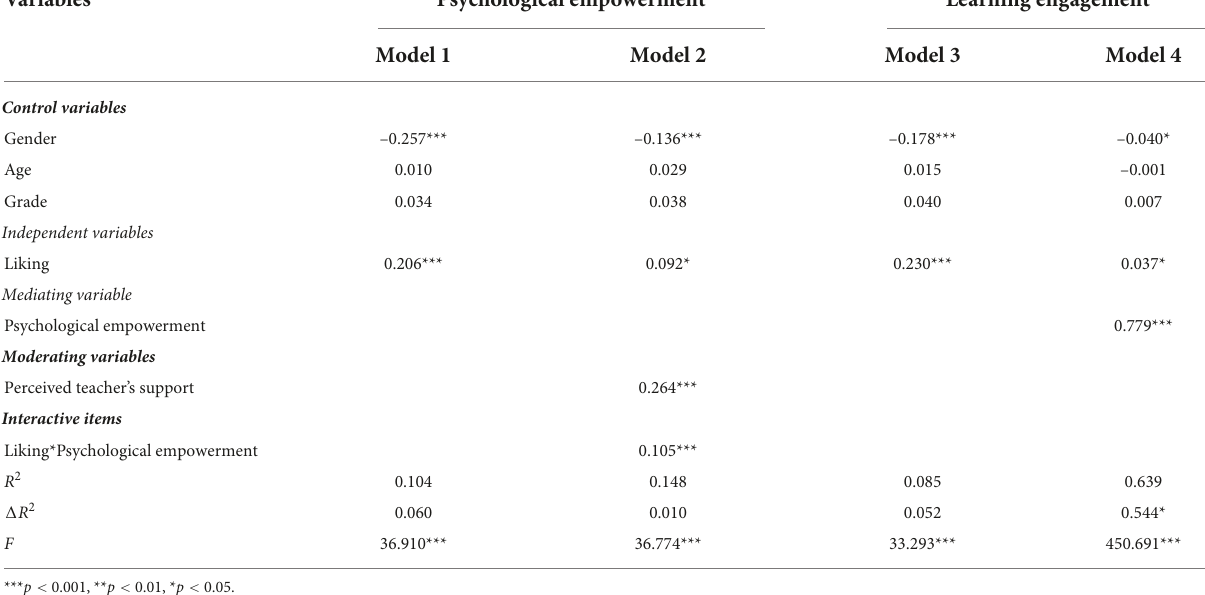
TABLE 3 Regression analysis model.